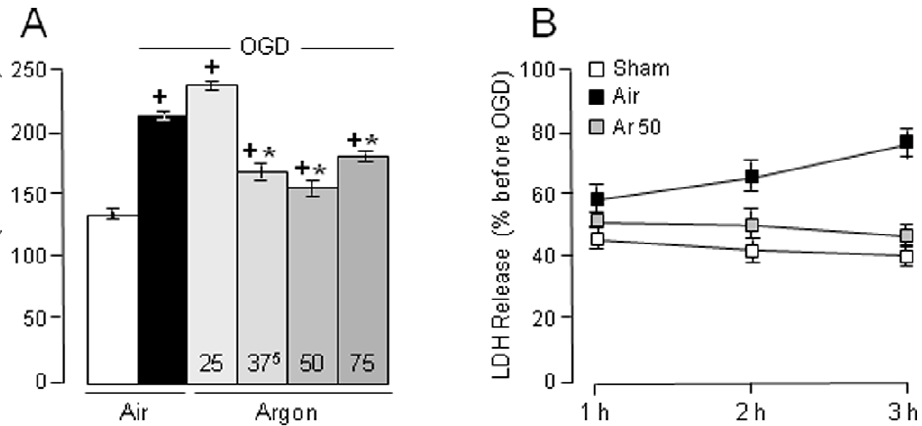
Figure 1. Reduction by argon (Ar) of OGD-induced LDH release. ( A ) Concentration-response effects of argon (Ar) on OGD-induced LDH release (n=23–27 per group). Exposure to OGD led to an increase in LDH release. Argon of 37.5 vol% to 75 vol% significantly reduced the increase in LDH release induced by OGD. ( B ) Time-course effects of OGD-induced cell injury and argon-induced neuroprotection. Cell injury induced by OGD as well as neuroprotection by argon increased as a function of time during the 3-h ‘‘reperfusion’’ period. Data are expressed as mean 6 SEM. * P , 0.05 vs OGD control slices; + P , 0.05 vs sham slices.